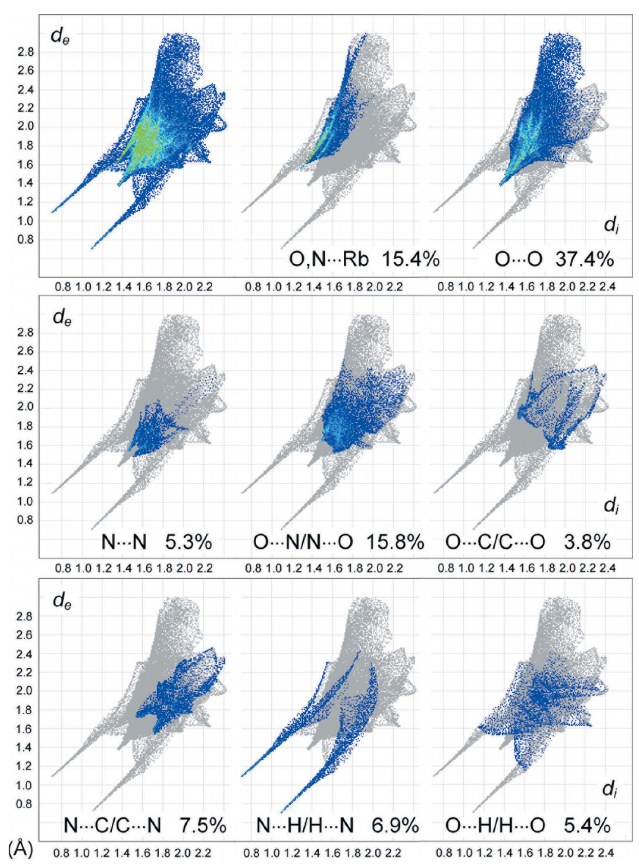
Figure 7 Two-dimensional fingerprint plots for the individual anions in ( 1 ), and delineated into the principal contributions of O,N (cid:2)(cid:2)(cid:2) Rb, O (cid:2)(cid:2)(cid:2) O, N (cid:2)(cid:2)(cid:2) N, O (cid:2)(cid:2)(cid:2) N/N (cid:2)(cid:2)(cid:2) O, O (cid:2)(cid:2)(cid:2) C/C (cid:2)(cid:2)(cid:2) O, N (cid:2)(cid:2)(cid:2) C/C (cid:2)(cid:2)(cid:2) C, N (cid:2)(cid:2)(cid:2) H/H (cid:2)(cid:2)(cid:2) N and O (cid:2)(cid:2)(cid:2) H/ H (cid:2)(cid:2)(cid:2) O contacts. Other contacts are C (cid:2)(cid:2)(cid:2) H/H (cid:2)(cid:2)(cid:2) C (1.5%) and C (cid:2)(cid:2)(cid:2) C (1.0%).